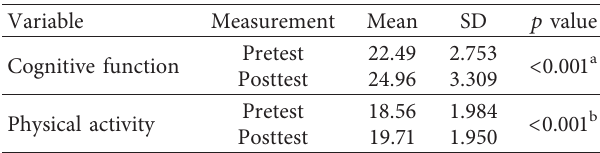
Table 5: Mean difference (mean) score of cognitive function and physical activity pretest and posttest in the intervention group in Dago Village Community Health Center working